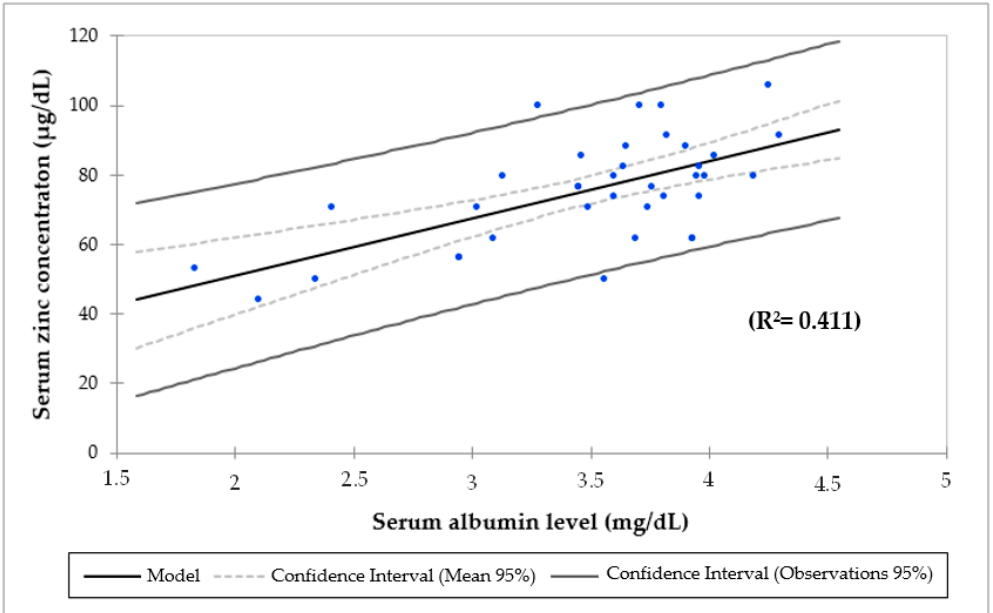
Figure 2. Linear regression analysis of serum zinc and albumin concentration before zinc supplementation.